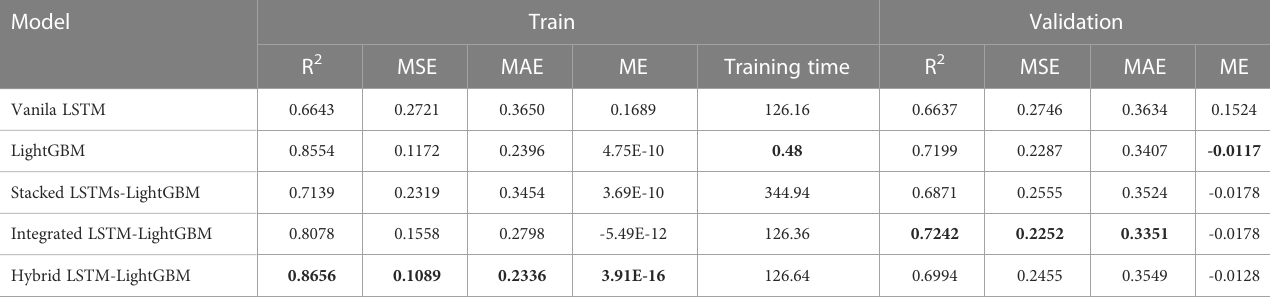
Best performance is highlighted in bold.